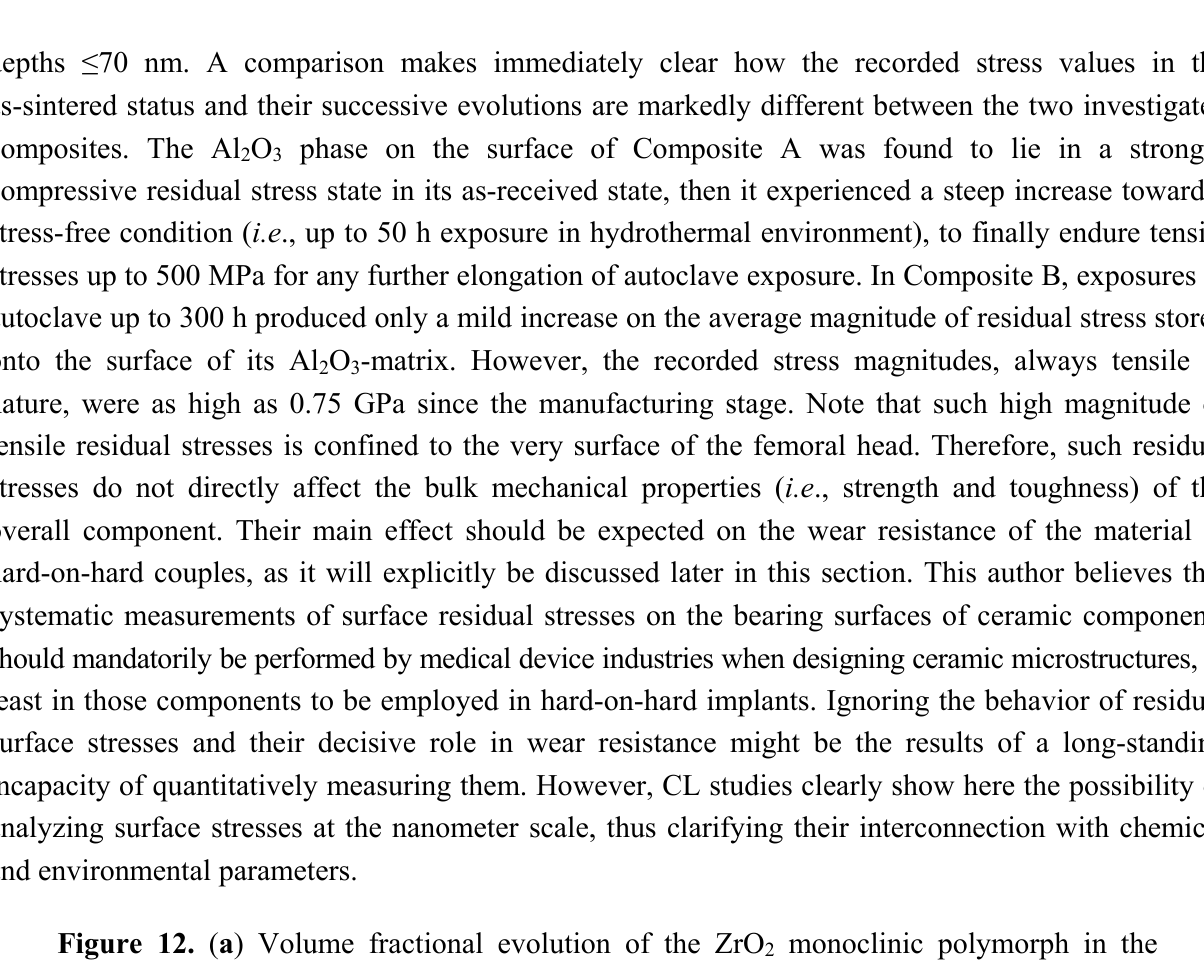
monoclinic polymorph in the 2 fractions); ( b ) evolution of the residual 2 O matrix phase of Composites A and B as a 2 3